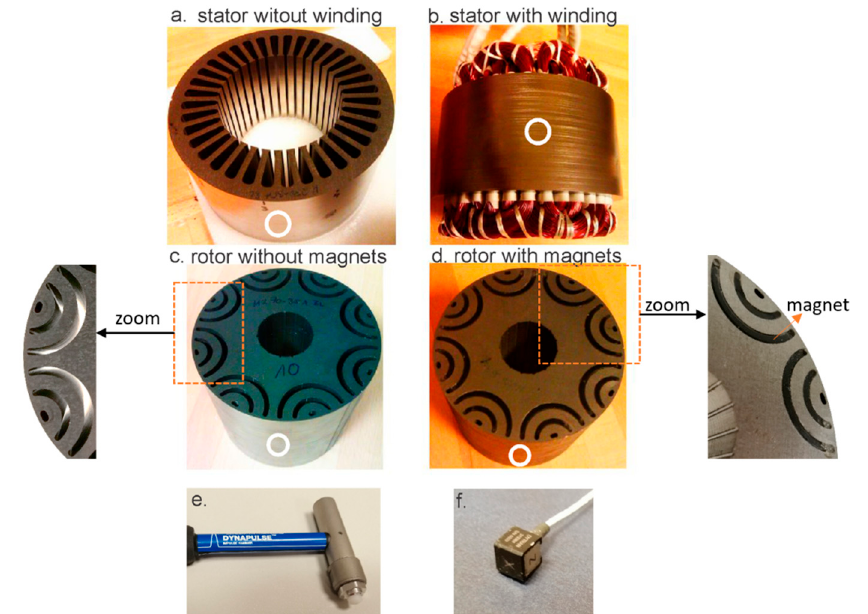
Figure 4. The prototyped components of the IPM motor, on which the experimental modal analysis was performed: ( a ) stator; ( b ) stator with slot windings and end-windings; ( c ) rotor without magnets and ( d ) rotor with permanent magnets, ( e ) impact hammer and ( f ) accelerometer sensor. The white circles indicate the position of the sensor. The displayed IPM components were prototyped in collaboration with the Slovenian company Kolektor Group d.o.o.